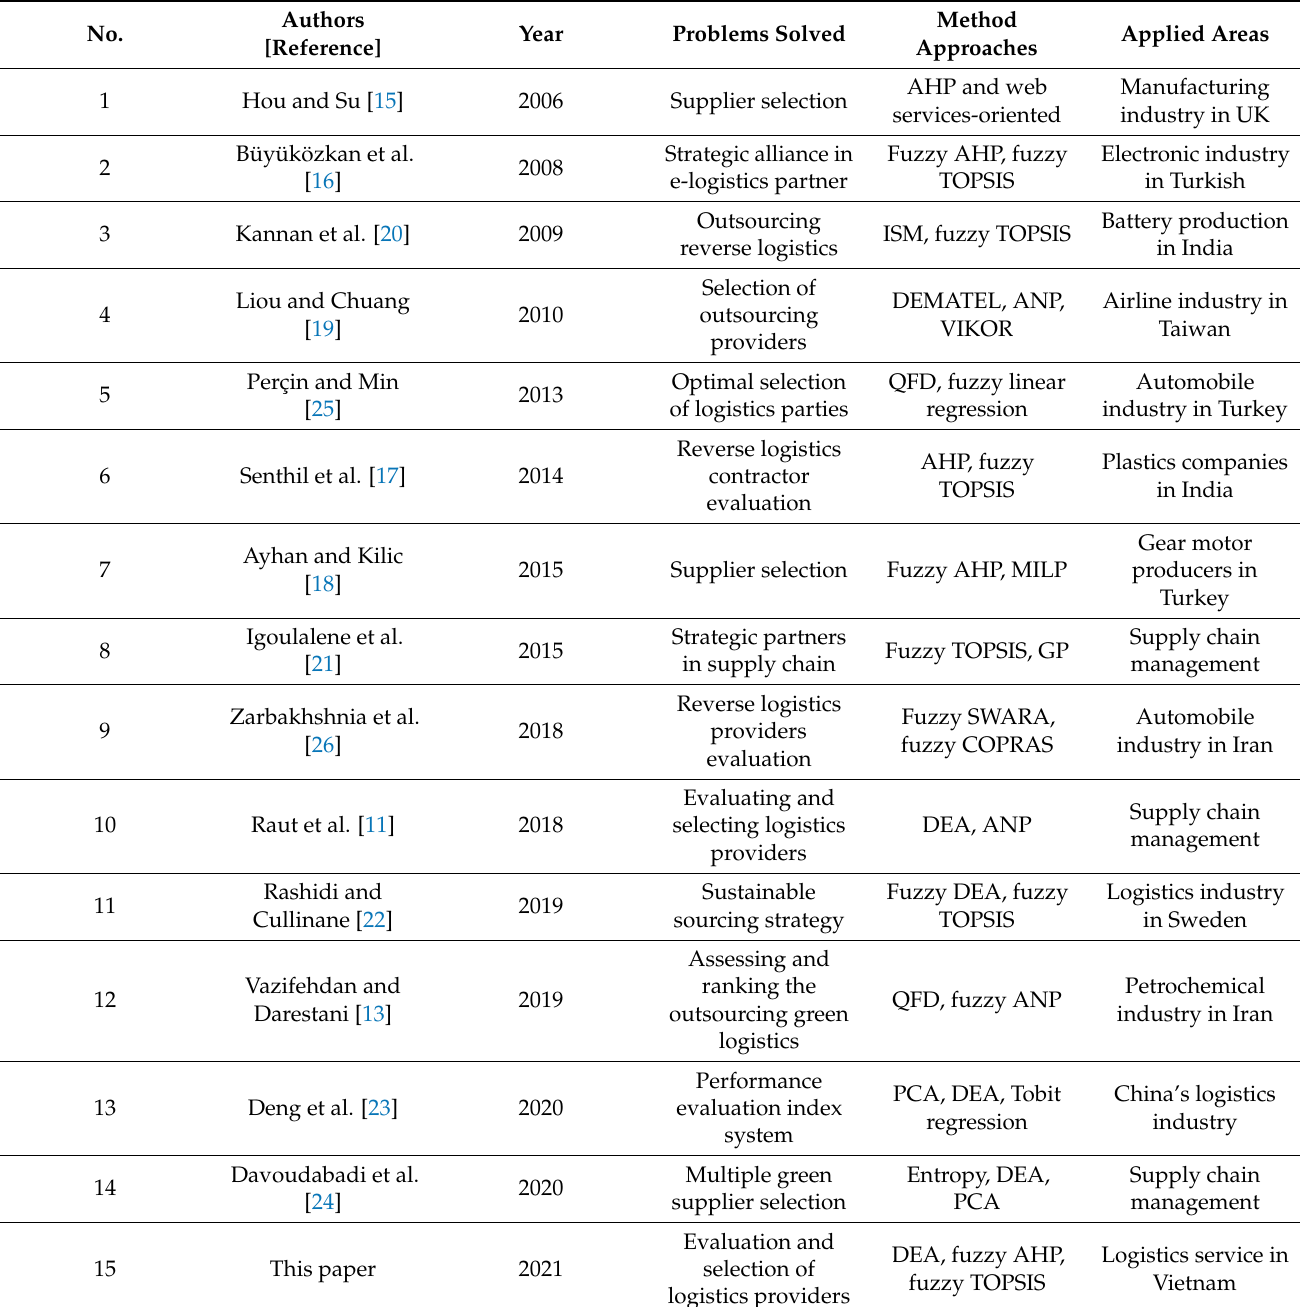
Table 1. The summary of method approaches applied in relevant